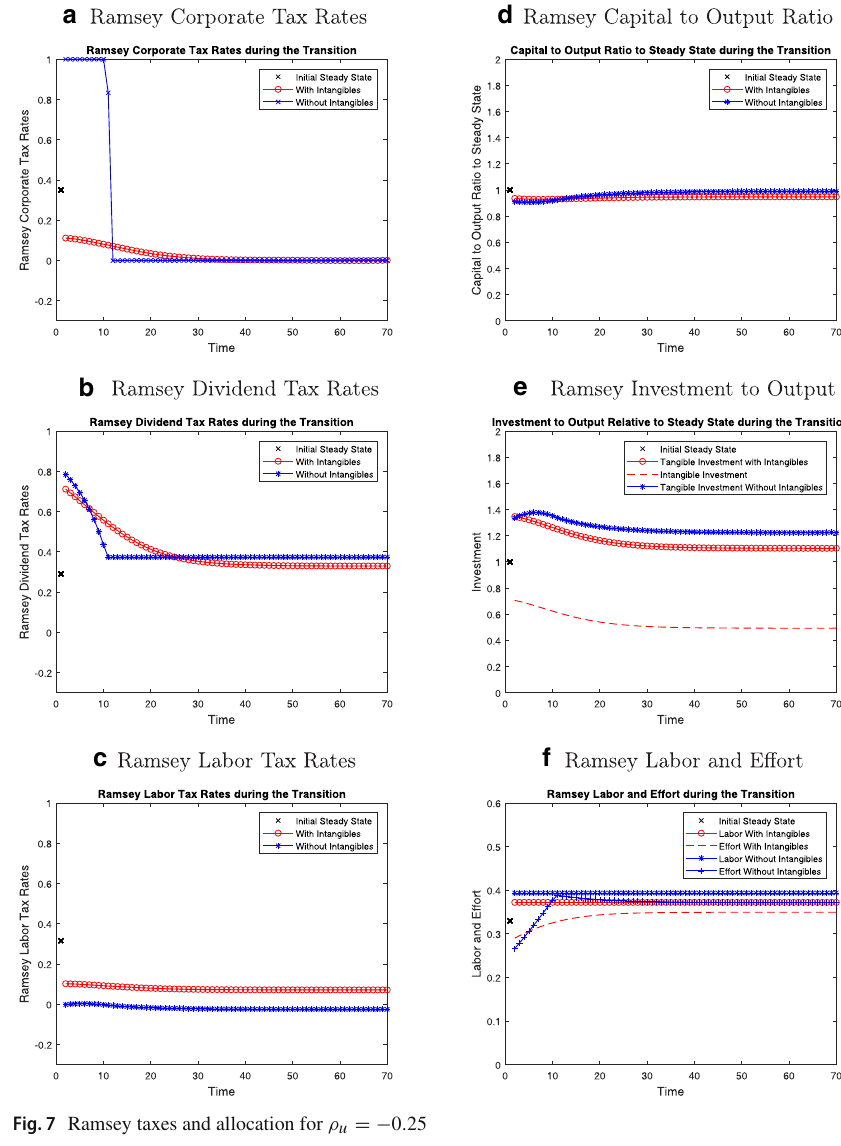
Fig. 7 Ramsey taxes and allocation for ρ u = − 0 .